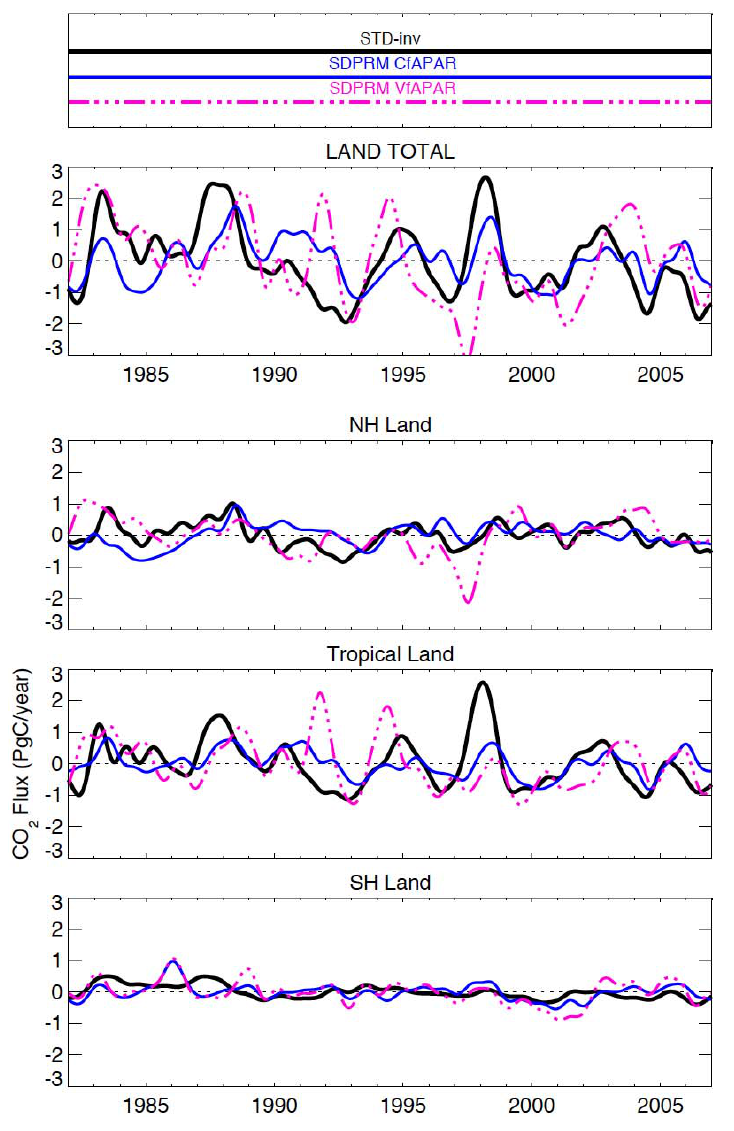
Fig. 5. The comparison between the anomaly (deviation from the mean of 1982–2006) of the IAV of the estimated NEE from SDPRM- CfAPAR (using the mean seasonal cycle of fAPAR) [Blue] and SDPRM-VfAPAR (using the full variability of fAPAR) [Magenta dashed] and the total land flux estimated by STD-inv [Black]. The time series are integrated over three latitudinal bands (for the map of the regions see Fig. 3) and de-seasonalized and filtered for interannual variability (as in Rödenbeck (2005)). The fossil fuel emissions have been subtracted for STD-inv